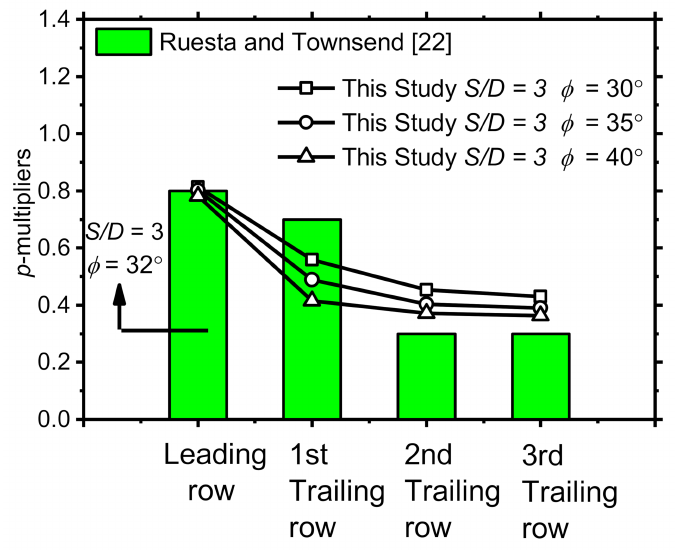
Figure 8. Comparison of p -multipliers for the free-head pile groups in sands calculated in this study with those measured from field tests with 4 × 4 pile configuration performed by Ruesta and Townsend [22].